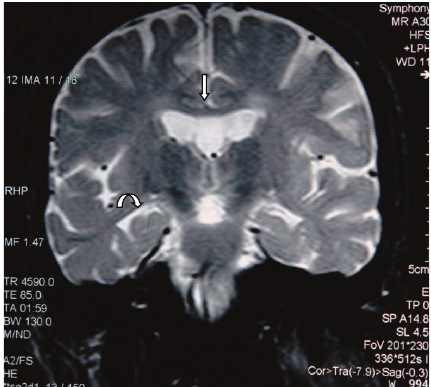
Figure 5: Coronal T2 weighted MR image of the brain shows bilateral hippocampal atrophy (curved arrow). Thinning of the corpus callosum also noted on this image with no evidence of signal intensity change (straight arrow).